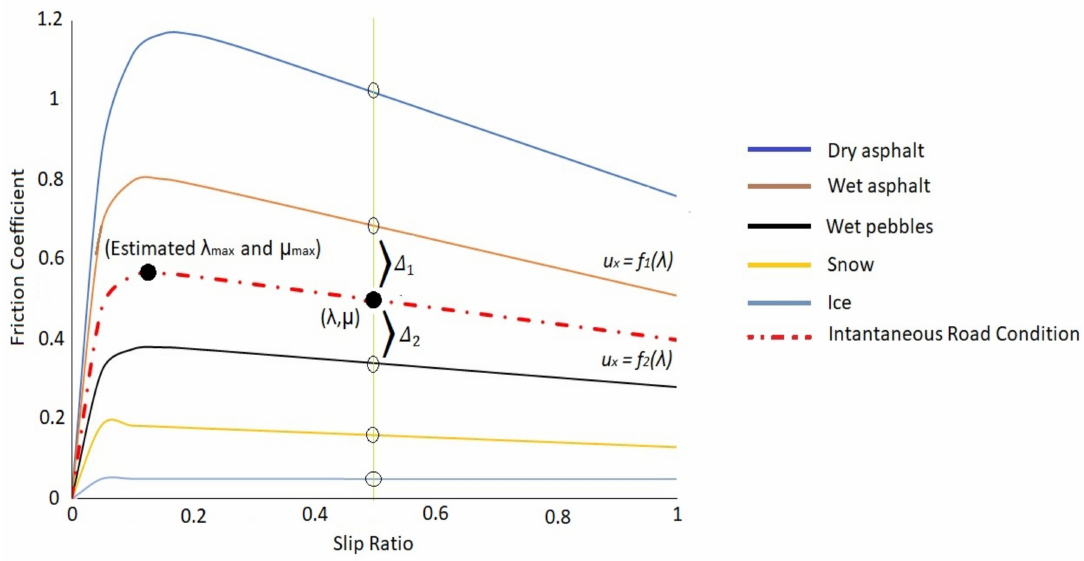
Figure 4. Optimum slip estimation [49,50] different font sizes and